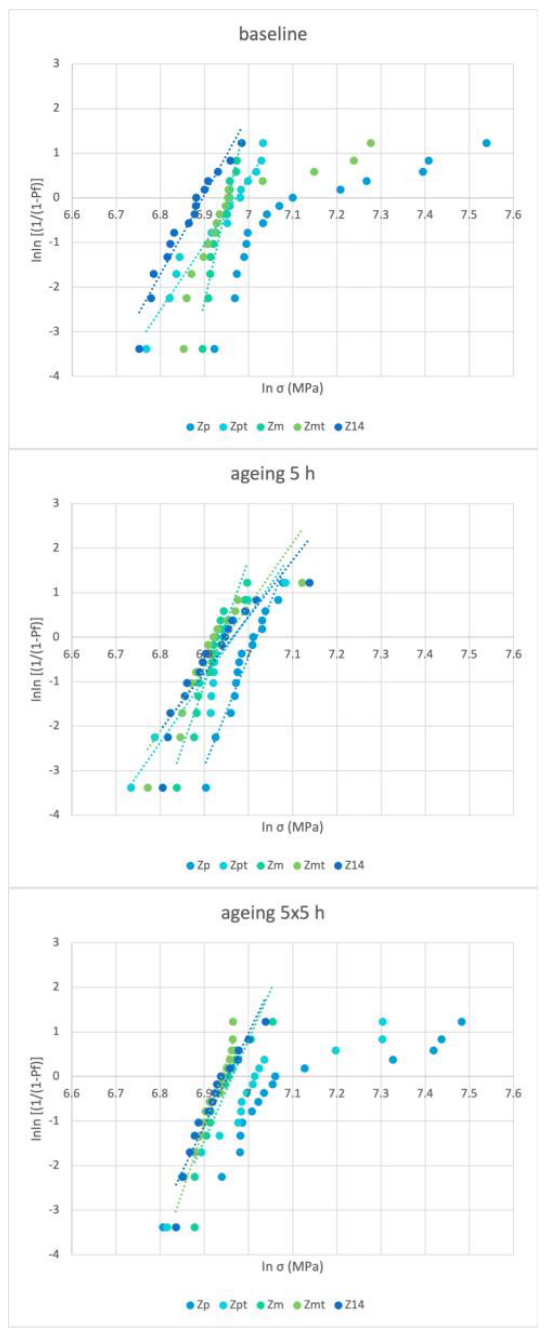
Figure 1. Weibull statistics of biaxial flexural strength values of zirconia with different surface treatments (Zp, Zpt, Zm, Zmt, and Z14) at baseline and after ageing 5 h and ageing 5 × 5 h.